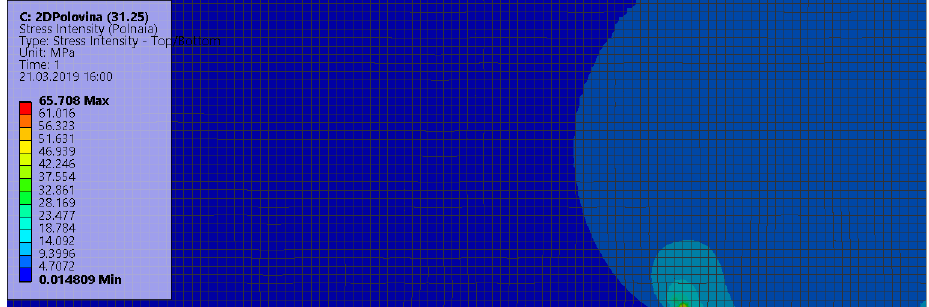
Fig. 10. Distribution of stress intensity σ i in the upper part of the deep beam